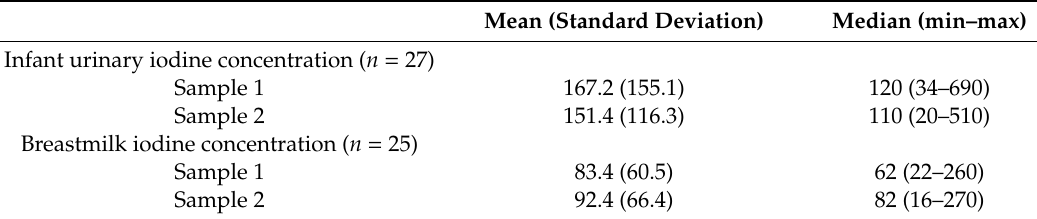
Table 2. Mean and median iodine concentration ( µ g / L) measured in two sets of samples from the infant’s urine ( n = 27) and in mother’s breastmilk ( n = 25).